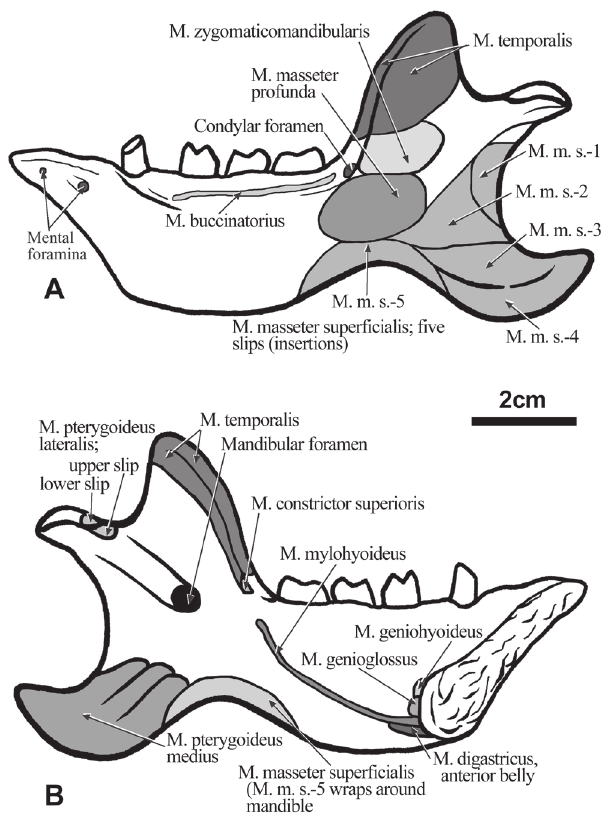
Figure 6. The mandible of Hapalops is shown in lateral view ( A ) and lingual view ( B ). The scars of muscle origin and insertion are labeled and